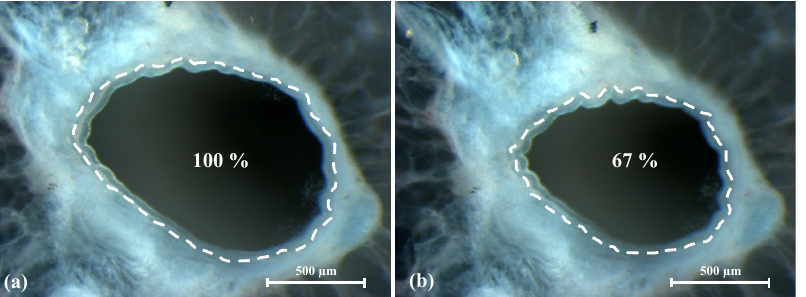
Figure 3. Cynomolgus PCLS of an ex vivo sensitized animal show bronchoconstriction after allergen exposure. Cynomolgus PCLS were passively incubated with 1% human serum containing HDM-specific IgE. Reduction of the initial airway area (in %) was assessed by video microscopy before (a) and after exposure to HDM (b) . (photographer: Elaine Cabral